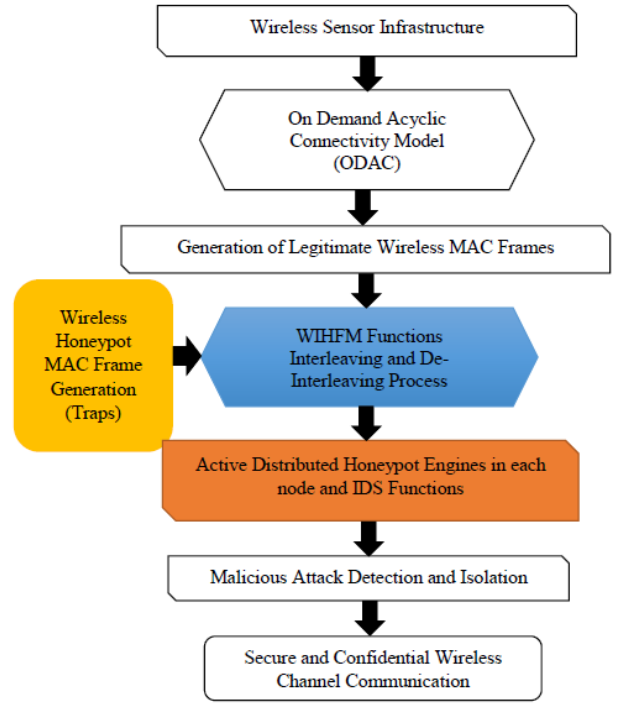
Figure 7. Design of WHIFM Phases.